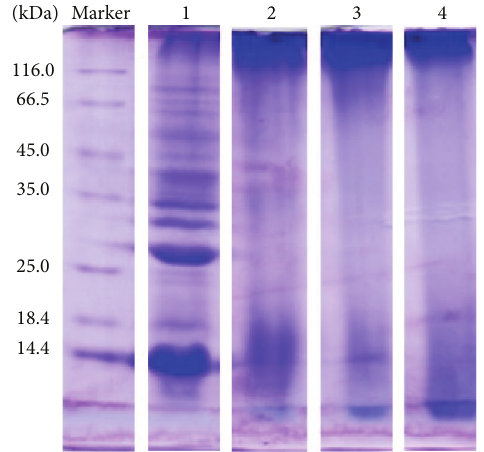
Figure 1: SDS-PAGE analysis of protein profiles: (1) untreated fresh NR latex, (2–4) fresh NR latex treated with C 5 H 8 O 2 50, 100, and 200 mmol/kg of latex.